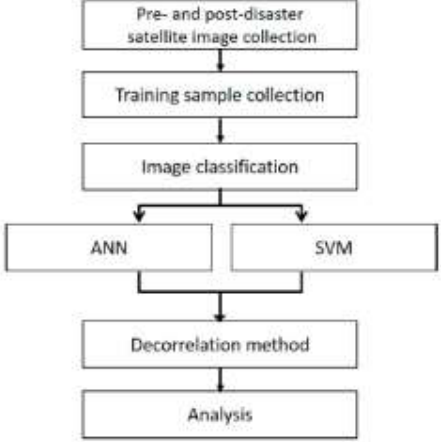
Figure 5. Flow chart of the method used to generate the damage maps (Syifa et al.